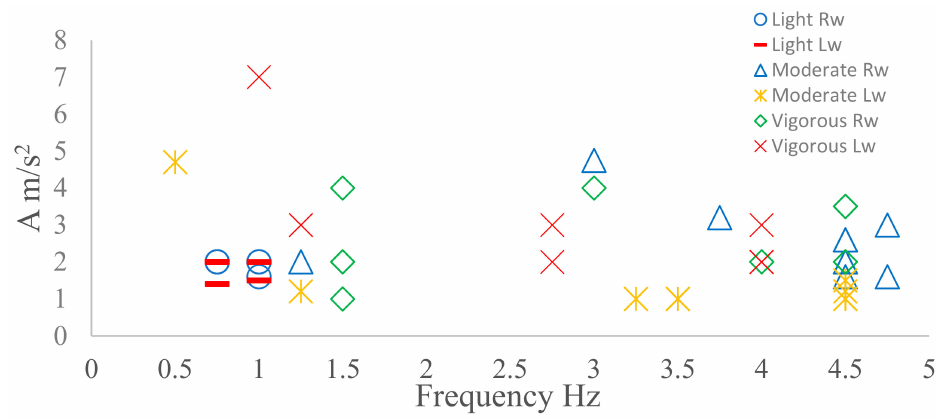
Figure 8. Right and left wrist dominant frequency and amplitude for di ff erent cycling intensities.